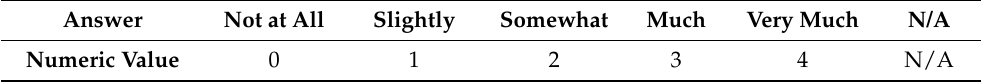
(Table 3) and “ D3: Employability Status (Employed or Not)” (Table 4) analysed. Table 1. Numeric values for Likert replies of